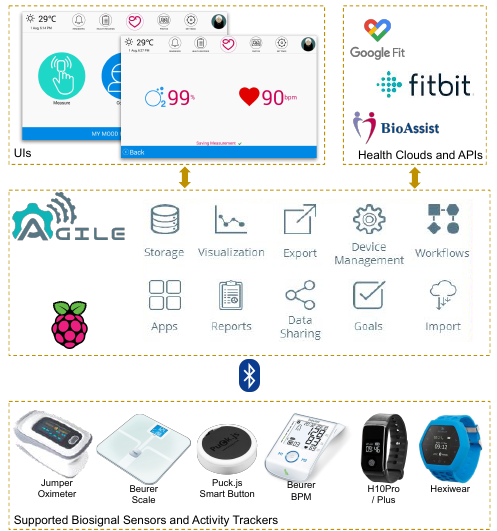
Figure 3. The Quantified Self